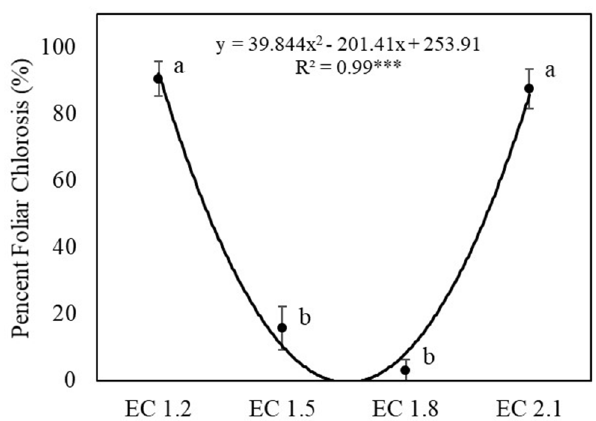
Figure 5. Effect of electrical conductivity (EC) of nutrient solution on a subjective rating of foliar chlorosis of arugula 4 weeks after transplanting into a nutrient-film technique hydroponic system containing nutrient solutions with EC 1.2, 1.5, 1.8, or 2.1 dS · m − 1 . Data points with different letters are significantly different according to Tukey’s test ( α = 0.05). Error bars represent standard errors ( n = 32). *** indicates significance at P of 0.001.